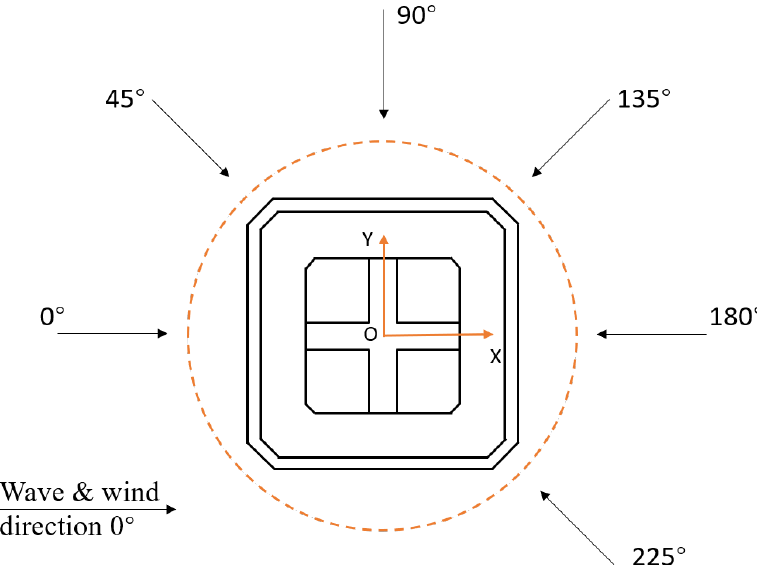
Figure 3. Schematic diagram of the direction of wind and wave propagation.